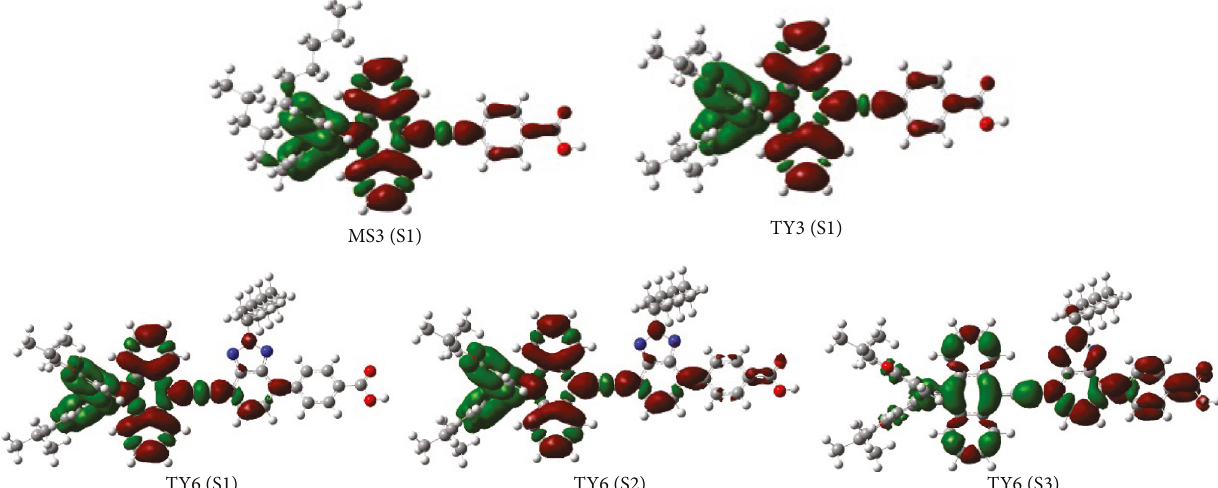
Figure 3: The charge di ff erence density (CDD) for MS3, TY3, and TY6 in solvent (green and red stand for the hole and electron,